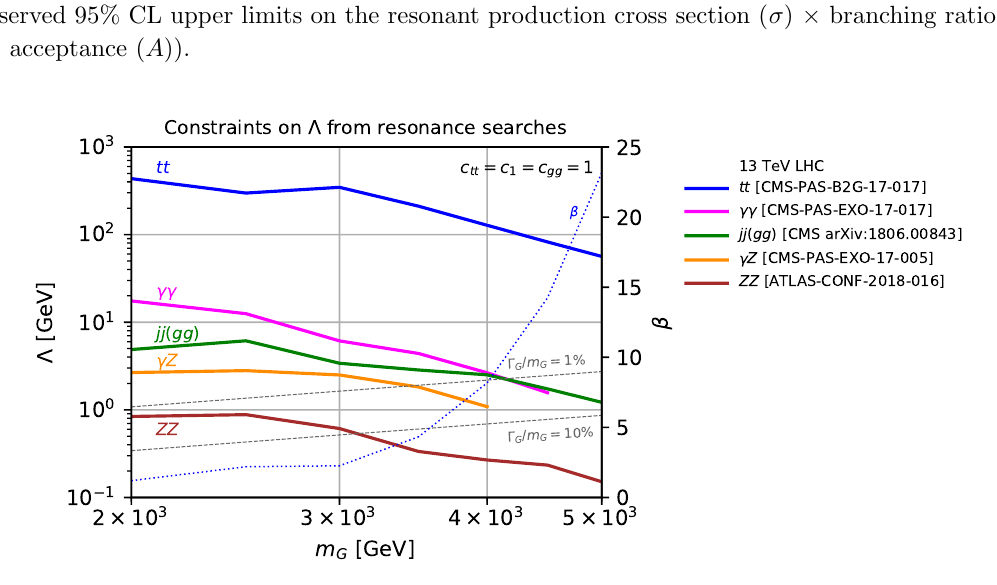
Figure 6 . Constraints on (cid:3) as a function of the KK graviton mass from the observed 95% CL lower limits of the resonance searches at the 13 TeV LHC with the regions below each line excluded, where the grey dashed and blue dotted lines correspond to the KK graviton width-to-mass ratio and (cid:12) = k= (cid:22) M Pl ,